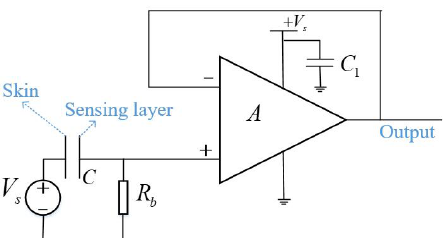
Figure 1. Equivalent electronic circuit of the active